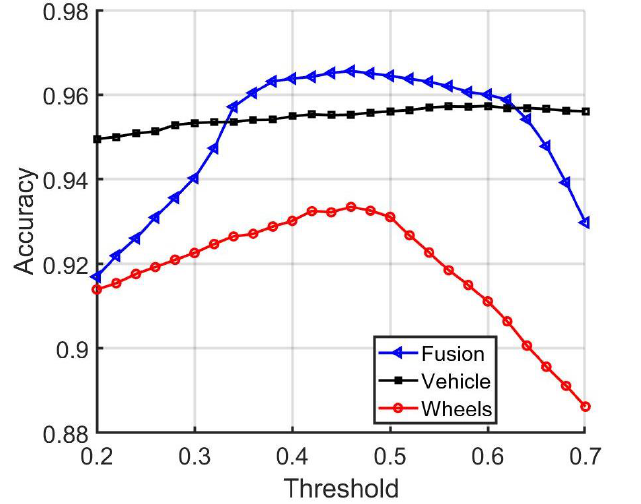
Figure 11. Comparison of the baseline, vehicle, and wheel-network-matching accuracies.